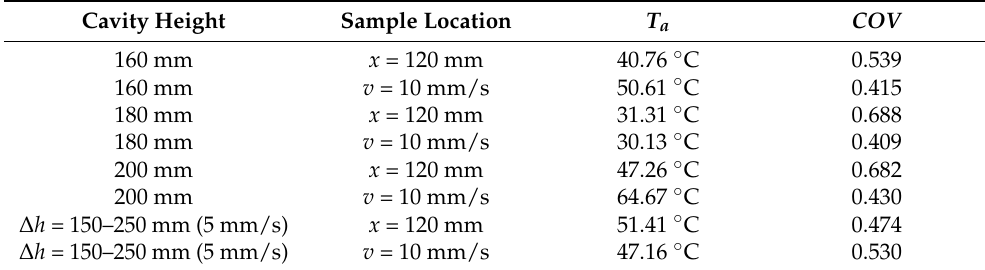
Table 2. T a and COV of the heated sample for 20 s under different conditions.